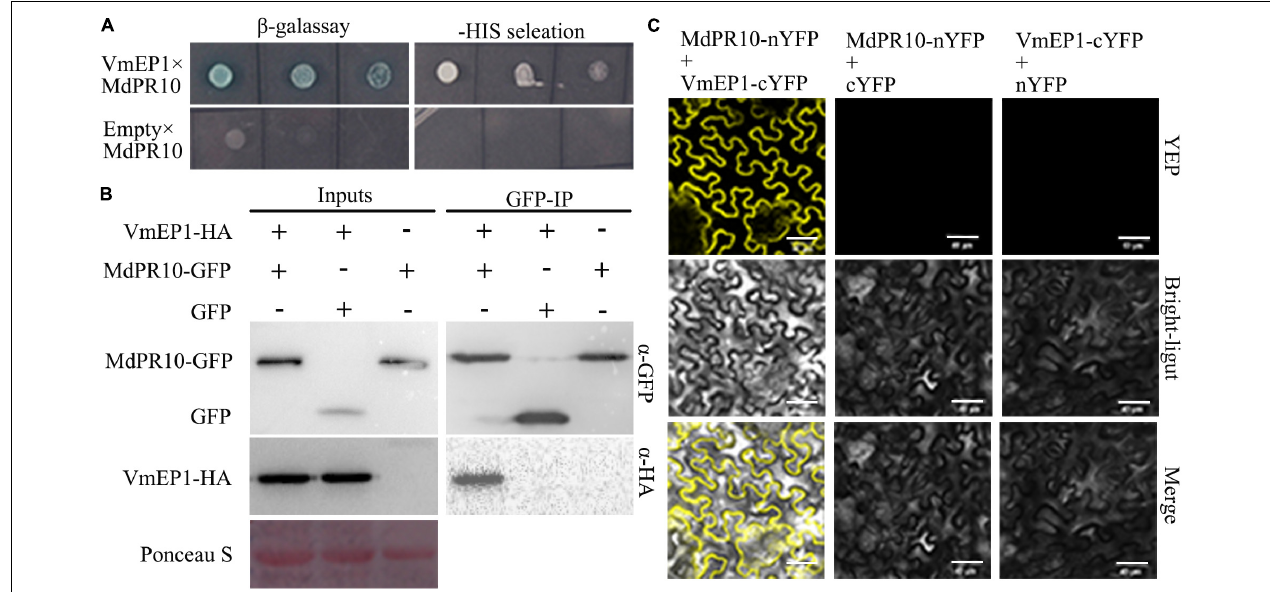
FIGURE 2 | Interaction between VmEP1 and Malus domestica pathogenesis-related 10 protein ( MdPR10 ) in vitro and vivo . (A) The positive yeast clones were cultured on SD-4 + X- α -Gal with ladder concentration of yeast suspension (10 − 1 , 10 − 2 , and 10 − 3 ) for further confirmation. (B) Bimolecular fluorescence complementation showed that VmEP1 interacted with MdPR10 in the leaf cells of N . benthamiana . VmEP1-cYFP and MdPR10-nYFP were co-expressed in N . benthamiana by agroinfiltration. The yellow fluorescence was observed 48–72 h post infiltration (Bars = 20 µ m). (C) In vivo Co-IP assay of HA: VmEP1 (without the signal peptide sequence) and green fluorescent protein (GFP)- MdPR10 . Both the genes were expressed in N . benthamiana leaves using agro-infection. The input experiment was performed by western blot with the HA antibody and GFP antibody to confirm the expression of the two proteins. The mixed proteins were blended with GFP-trap agarose beads. The final eluent was analyzed by immunoblot using the above-mentioned antibodies to detect VmEP1 and MdPR10 . This assay was repeated three